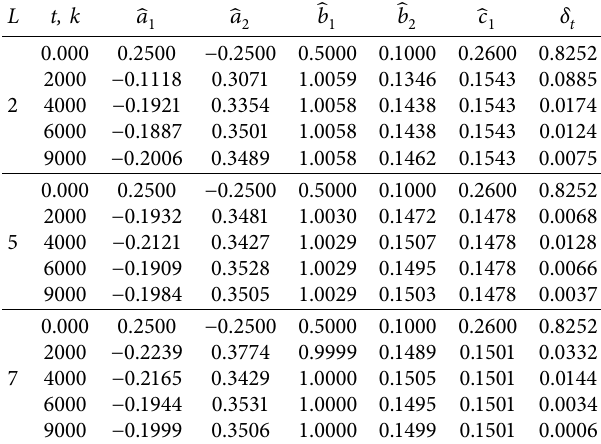
Table 8: The vector parameter estimates 􏽢 θ errors δ t for the FSOEAHW model using MIFIBPG algorithm with L � 2, 5, and 7.